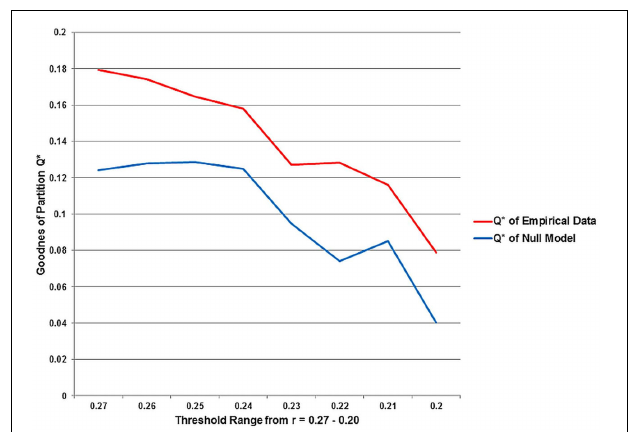
FIGURE 7 | The statistical significance of the three second level analysis modules. The figure illustrates the values for the goodness of partition Q ∗ for the empirical data and for equivalent random networks over the entire investigated threshold. The value for Q ∗ shows the typical progress and decreases monotonically as the threshold gets more liberal. The Q ∗ -values for the equivalent random networks are strikingly smaller than for the empirical